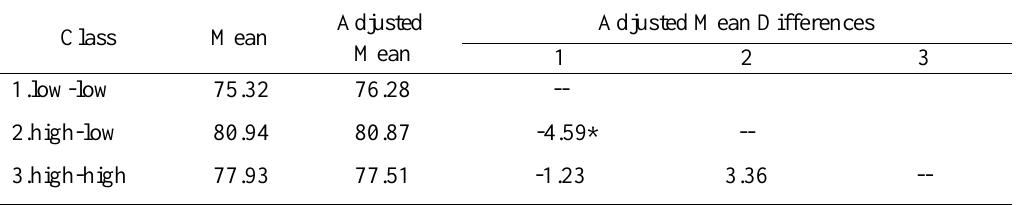
Table 4 Pairwise Comparisons of English Achievement by Motivation